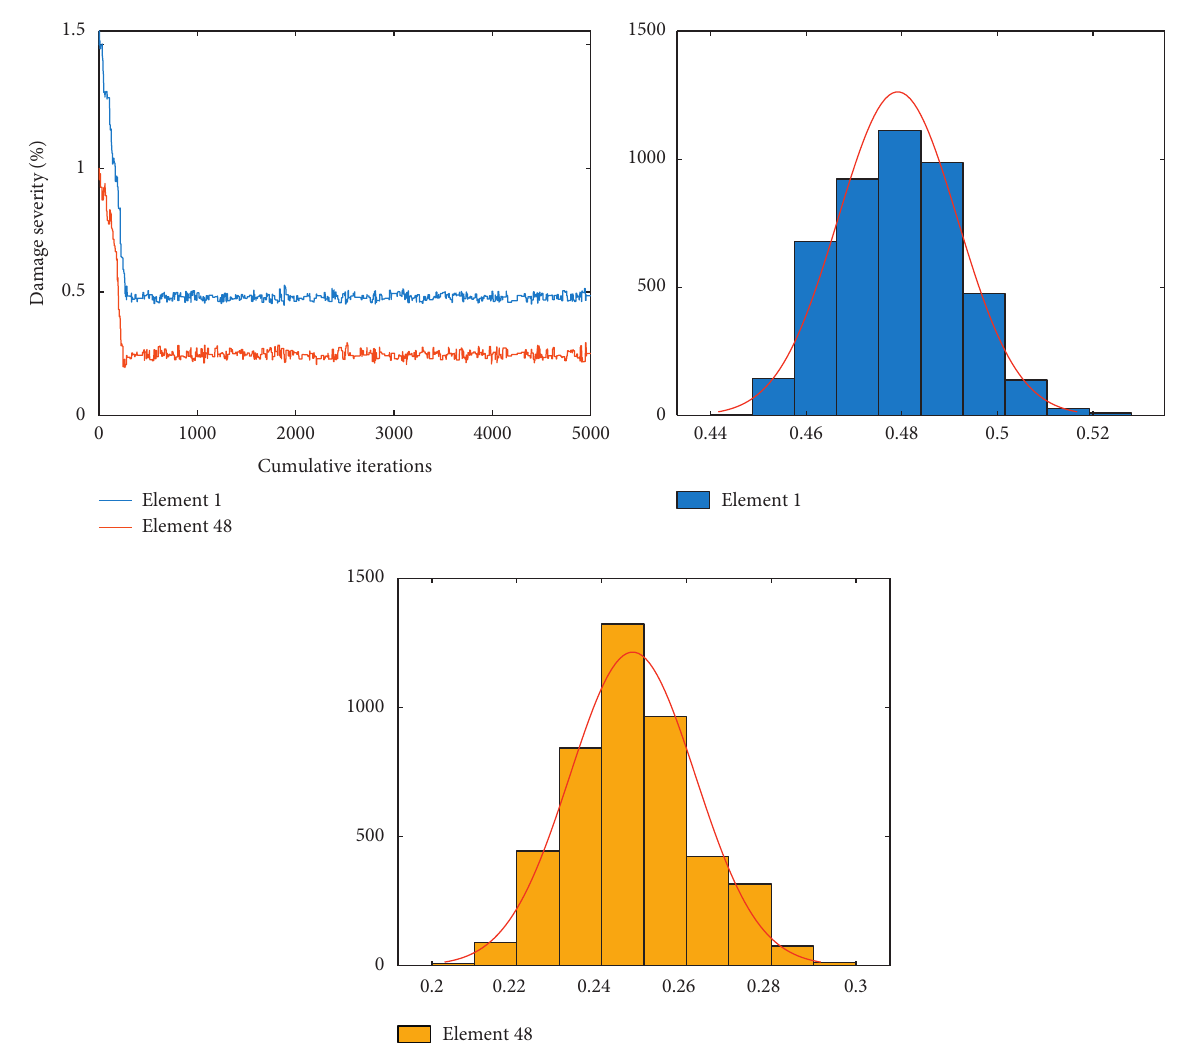
Figure 8: The Markov chains and histograms of damage case 1.